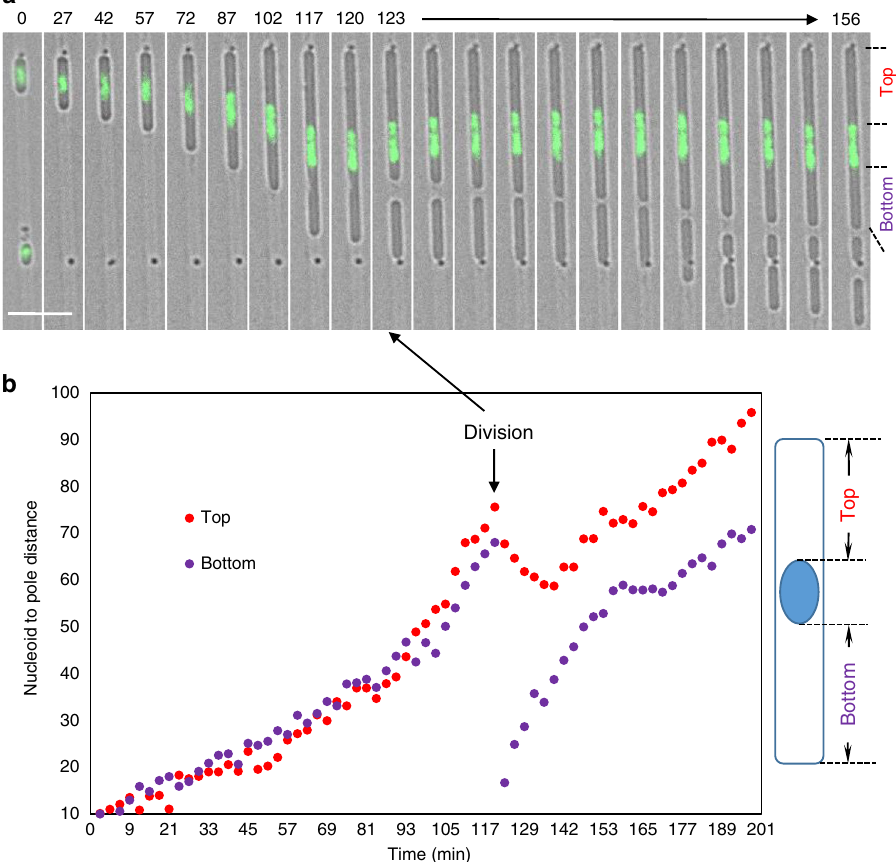
Fig. 6 Re-centring of the single nucleoid after asymmetric division in narrow channels. a Selected still images from a time-lapse experiment also shown in Supplementary Movie 13, showing a single-nucleate cell growing and dividing in the narrow channel. The merge of the bright fi eld image (grey) and the green fl uorescence image of the chromosomal DNA labelled with HU-GFP (green) is shown. After division the asymmetrically located nucleoid moved towards the distal pole to re-centre itself. Such events, which occurred in similar experiments, could be clearly observed only in large cells that had a single nucleoid and divided near the nucleoid, and had a suf fi ciently long time gap before the second division occurred. More examples are shown in Supplementary Fig. 5. L -forms of strain 4739 (LR2 Ω amyE :: neo hbsU-gfp) were grown in the presence of the DNA replication inhibitor HB-EmAu in liquid culture and after introduction into a micro fl uidic device. Scale bar, 5 µ m. b Distances of the nucleoid to the two cell poles over a 2.5 h time course. The distance (arbitrary unit) between the polar edge of the nucleoid to the nearest pole was measured, as explained in the cartoon on the right. Division that occurred at the 123 min frame is marked by